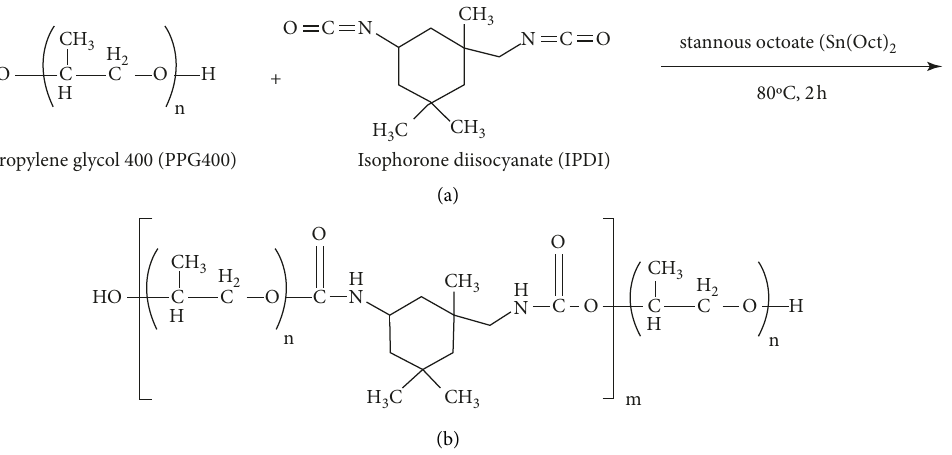
Figure 1: Synthesis reaction (a) and structure of UPGO structure